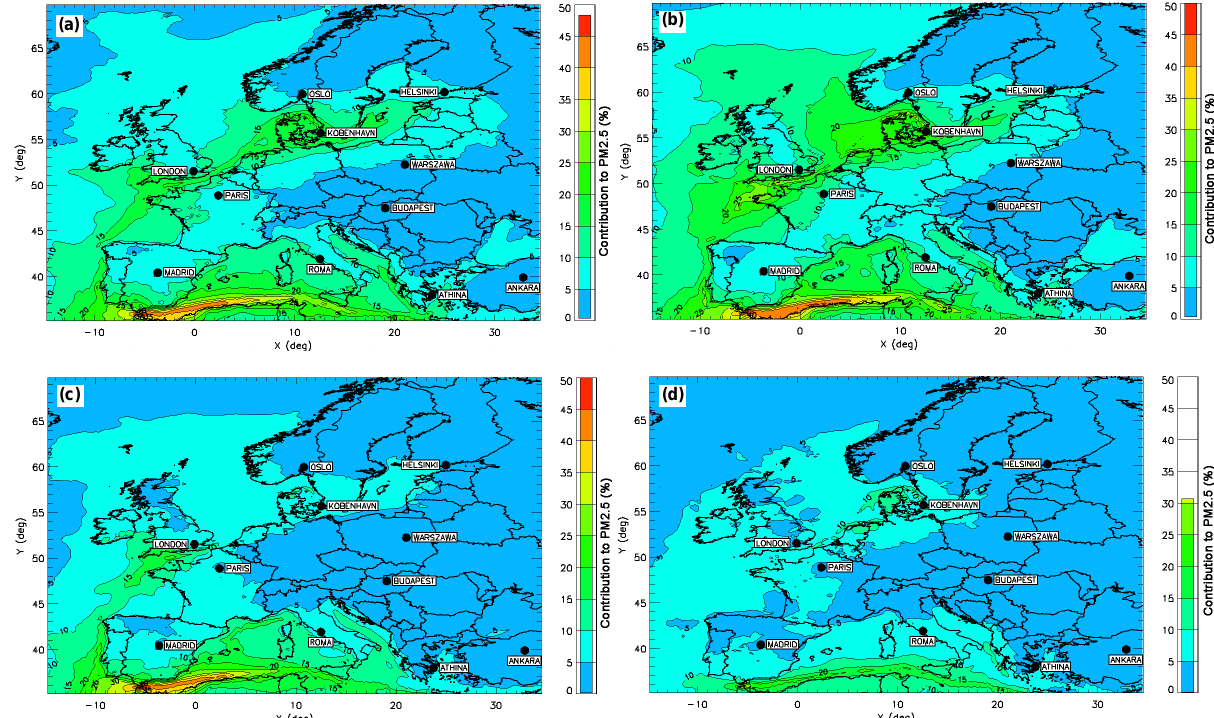
Figure 4. Contribution of ship emissions to PM 2 . 5 (%) in (a) spring, (b) summer, (c) fall, and (d) winter ((base case − no ship) × 100/(base case)).